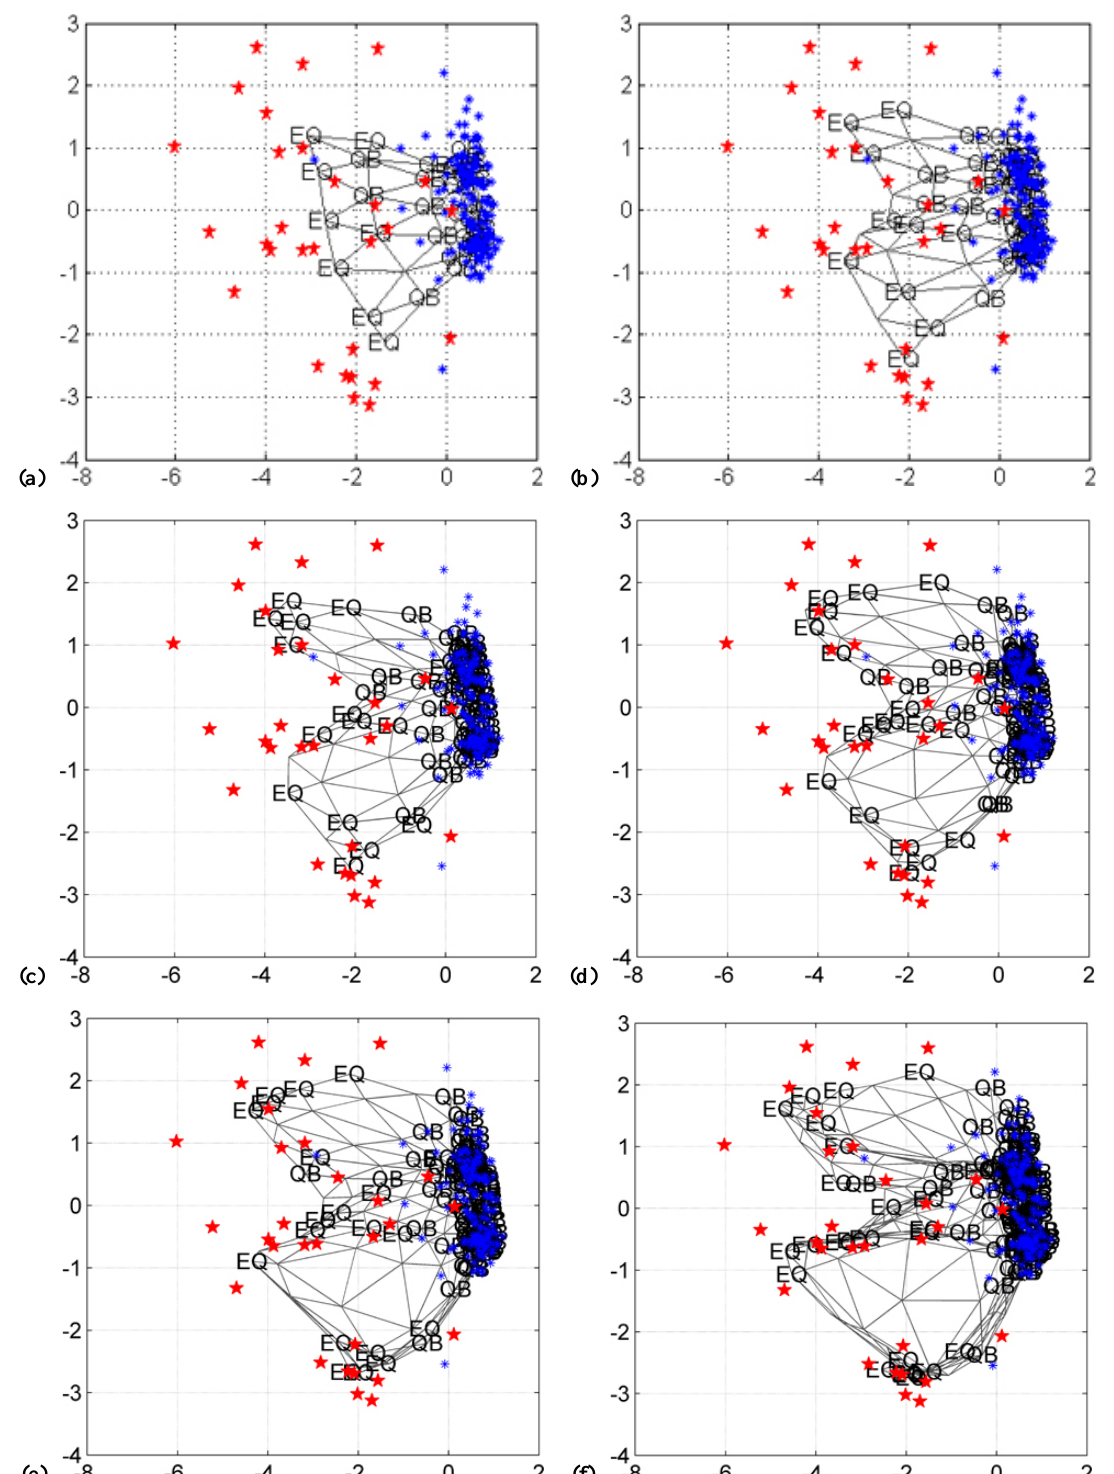
Fig. 3. SOM and projection of the seismic events onto the subspace spanned by its two eigenvectors with greatest eigenvalues for different map-sizes. Red stars indicate earthquakes (EQs) and blue asterisks represent quarry blasts (QBs). Neighboring map units are connected with gray lines. Labels associated with map units are also shown on nodes (neurons). Parts (a) , (b) , (c) , (d) , (e) , (f) correspond to 6 × 6, 8 × 8, 10 × 10, 12 × 12, 14 × 14 and 20 × 20map-sizes, respectively. As the map size is enlarged, the SOM algorithm adapts to distribution of the input